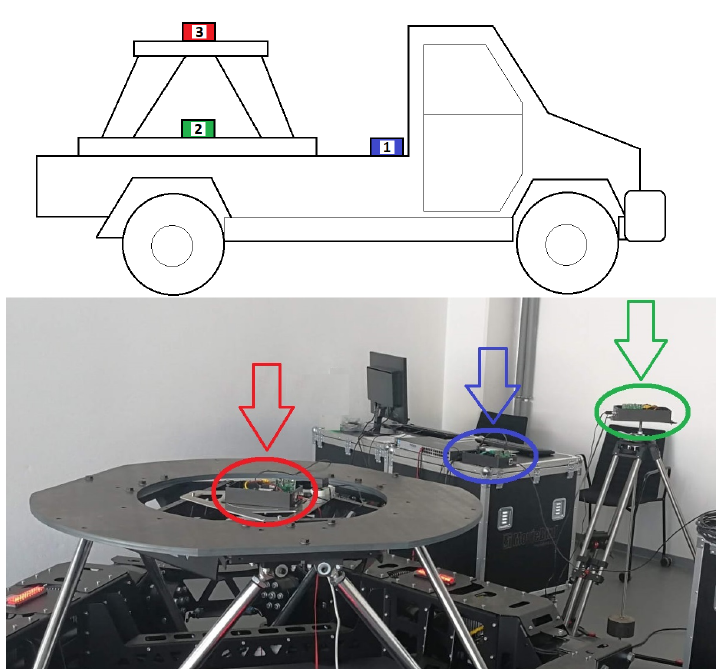
Figure 4. A module configuration (colored shapes): vehicle vs. laboratory instances [Source: MovieBird Intl.].